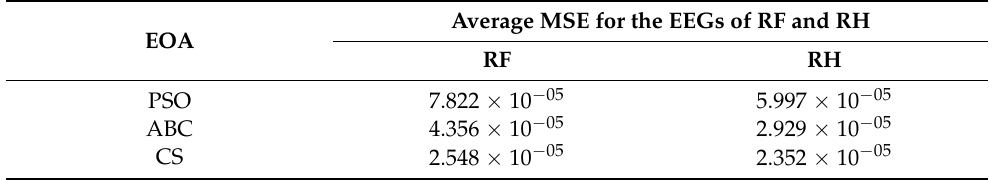
Table 1. The average MSE obtained for the EEGs of RF and RH brain activities using three EOA.